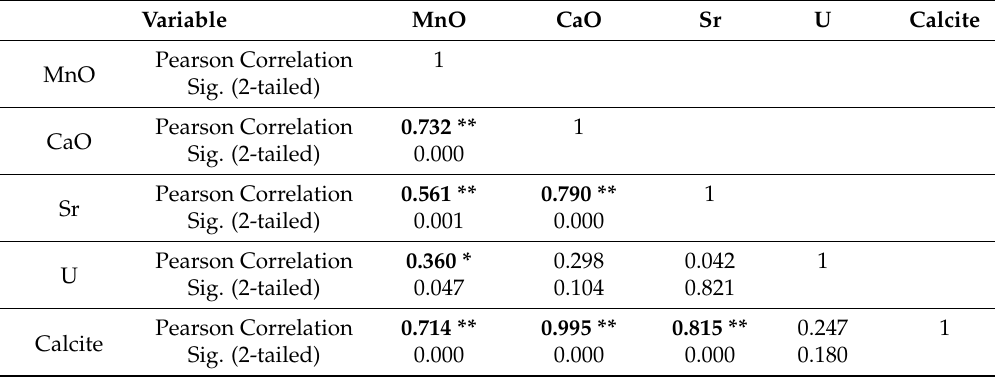
Table 5. Bivariate correlation matrix of MnO, CaO, Sr, U and